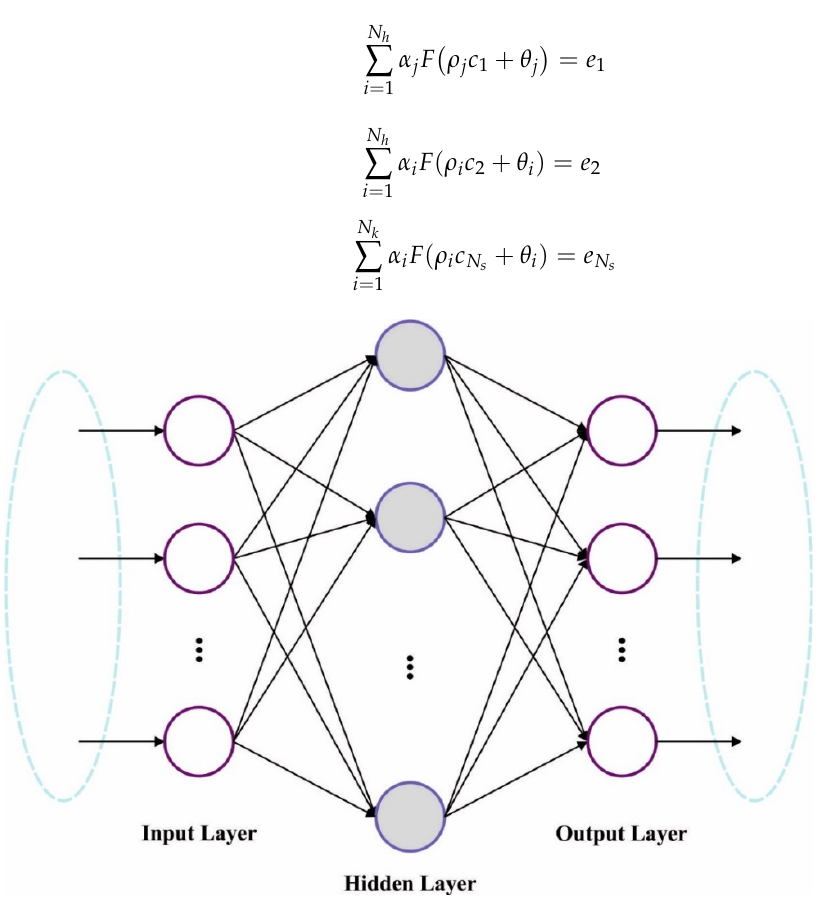
Figure 2. Architecture of